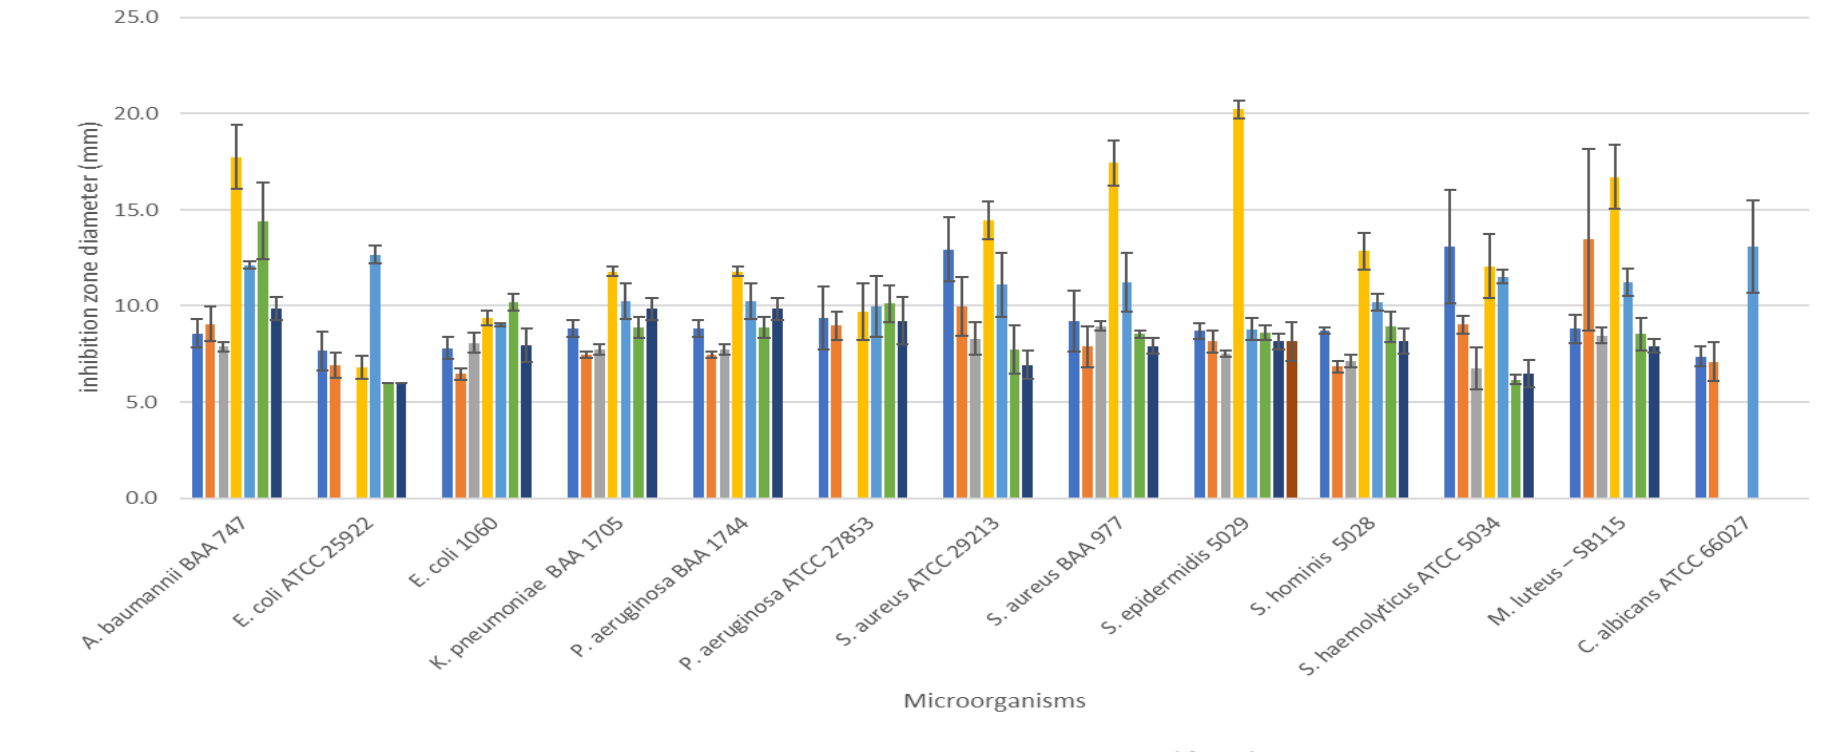
Figure 2. The zone of inhibition diameters of the prepared hand sanitizers compared to three commercially available hand sanitizers (C1, C2, and C3) against the 12 gram-negative and gram-positive bacterial strains and C. albicans yeast. The results represent the mean of three independent experiments ± SD (n = 3). It was shown that the clove hand sanitizers (F1 and F2) were able to inhibit all bacterial strains and the yeast, similar to one control (C1). In contrast, the tea tree hand sanitizer had the highest efficient antibacterial activity, but lacked anti-yeast activity.